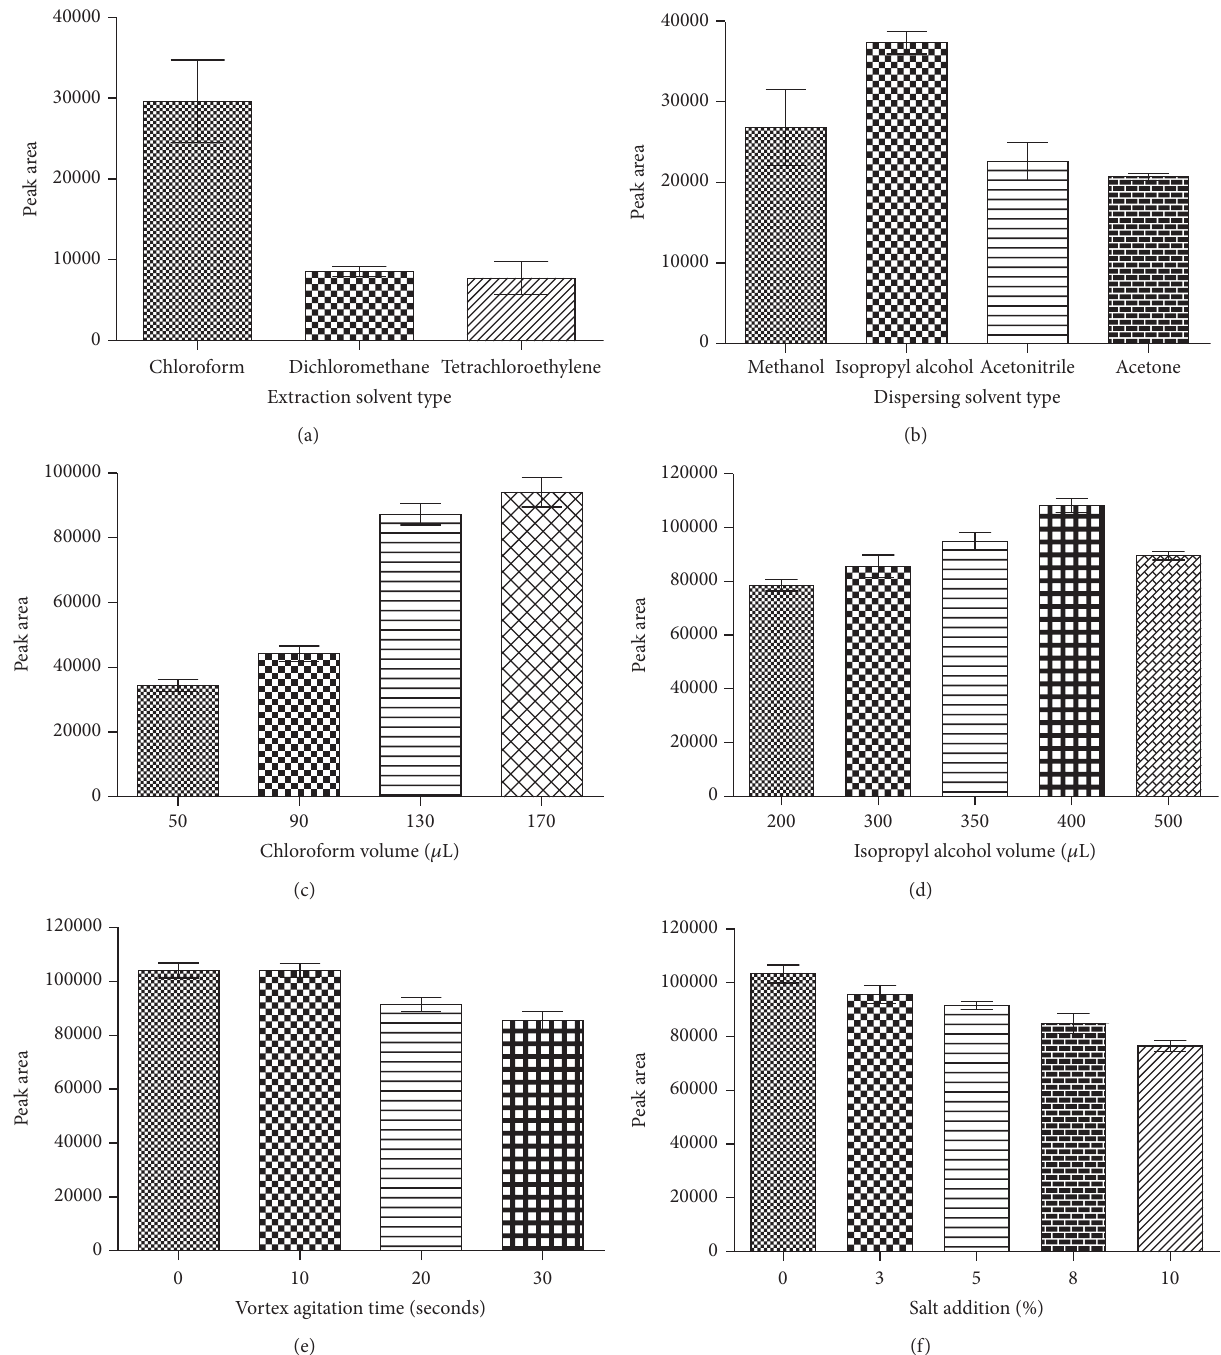
Figure 3: Optimization of DLLME procedure: (a) extraction solvent type, (b) dispersing solvent type, (c) extraction solvent (chloroform) volume, (d) dispersing solvent (isopropyl alcohol) volume, (e) vortex agitation time, and (f) salt addition.